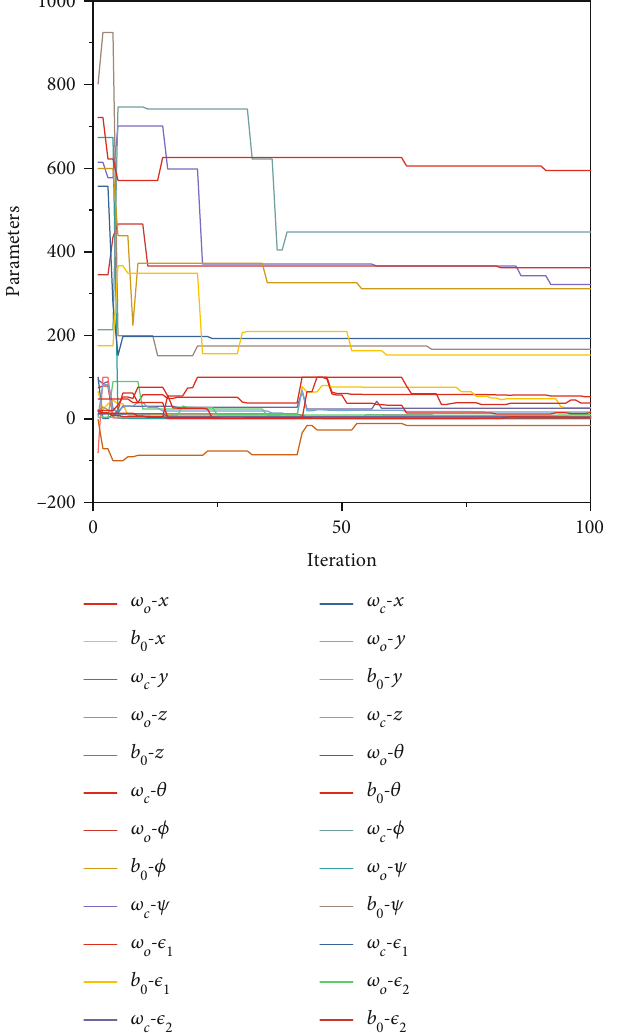
Figure 6: Dynamic process of parameter tuning.